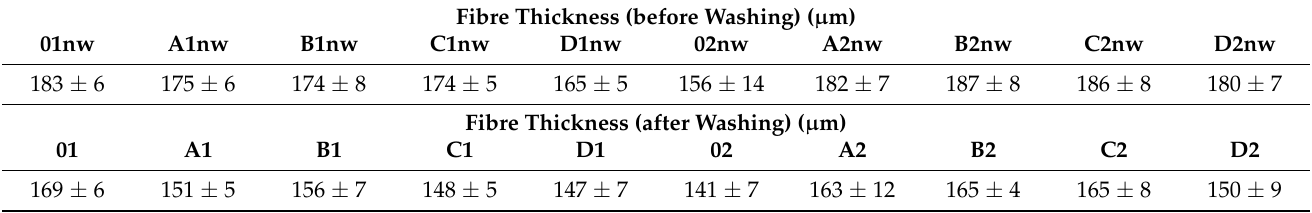
Figure 5. A measurement of thickness fibres by using the FibreMetric software; ( a ) surface of fibres (300 × magnification) and ( b ) histogram (an example for fibres C1). Table 3. Summary of the median values of results of the fibre thickness